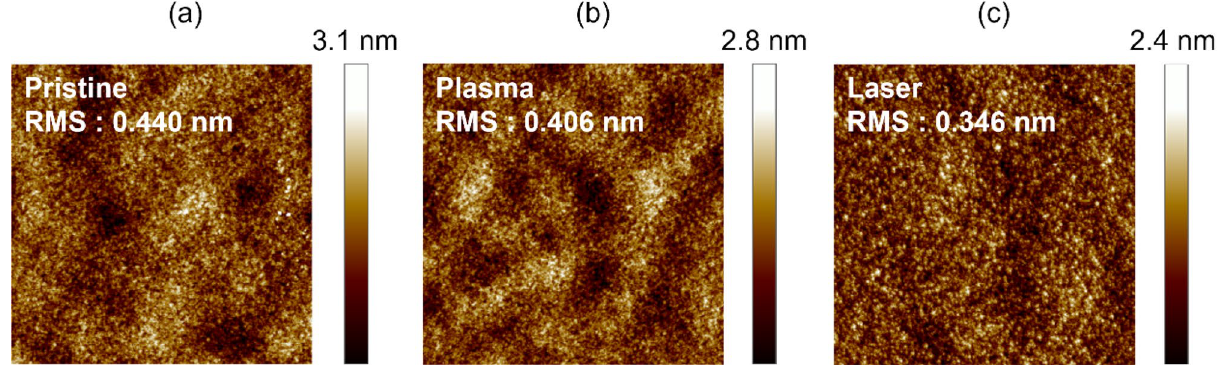
Figure 2. AFM images of multi-stacked IZO thin-film surfaces under ( a ) pristine, ( b ) plasma, and ( c ) femtosecond laser pre-annealing.